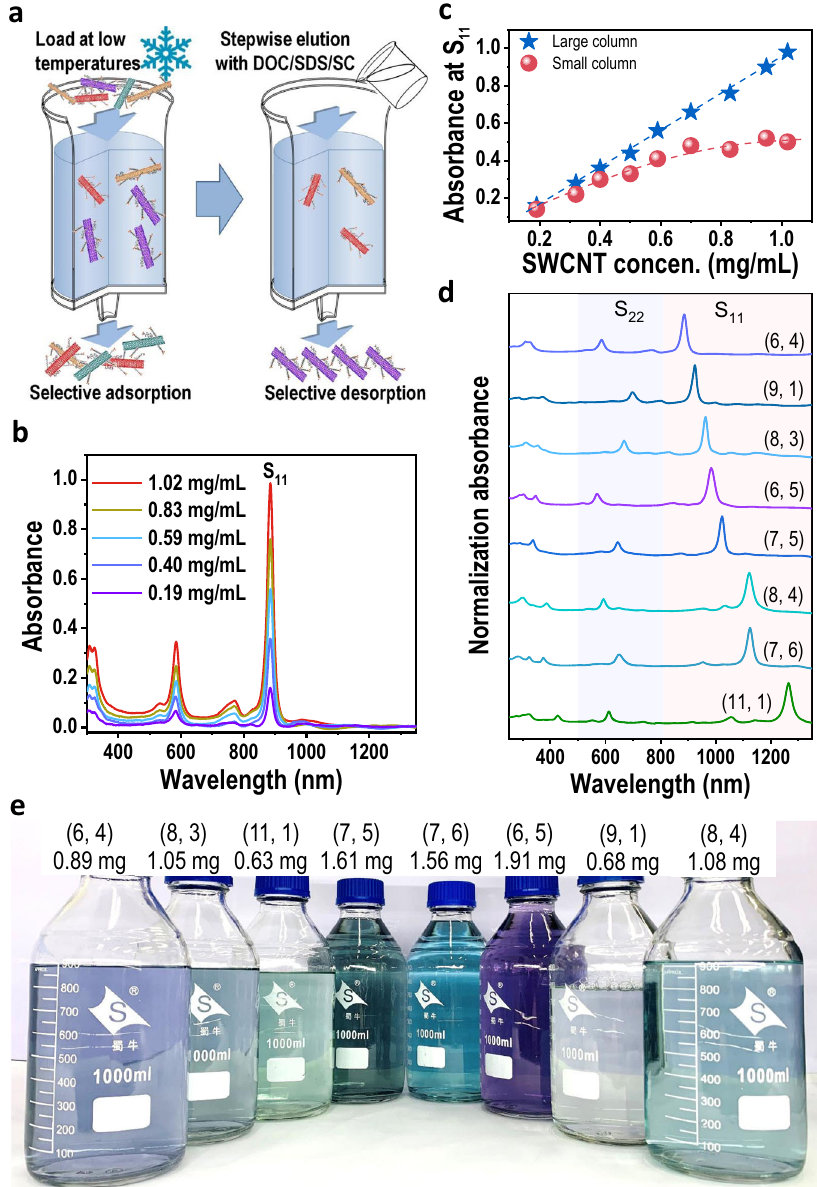
Fig. 2 | Milligram-scale separation of single-chirality SWCNTs from a high- concentration individualized SWCNT solution. a Schematic diagram of the separationofsingle-chiralitySWCNTs.DOC,SC,andSDSrepresentsodiumcholate, sodiumdeoxycholate,andsodiumdodecylsulfate. b Opticalabsorptionspectraof single-chirality(6,4)SWCNTsfromSWCNTsolutionswithdifferentconcentrations using a 40-mL gel. The separated (6, 4) solutions were diluted to 20mL for